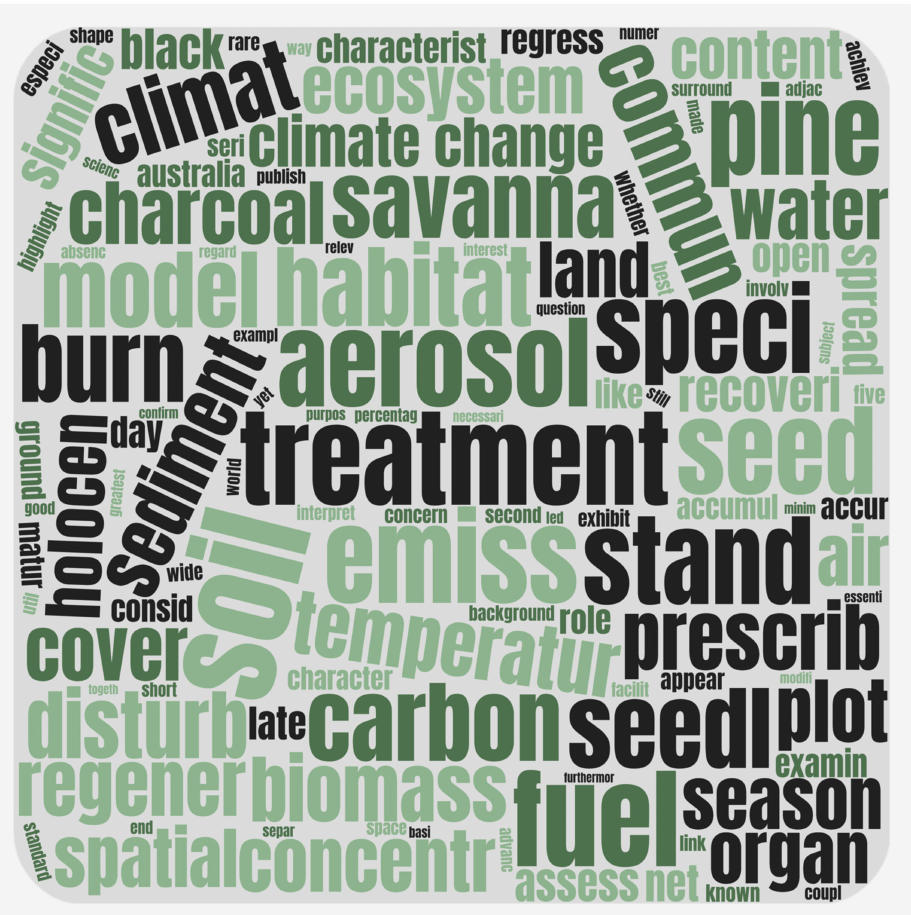
Figure 3. Word cloud of indexed words considering importance